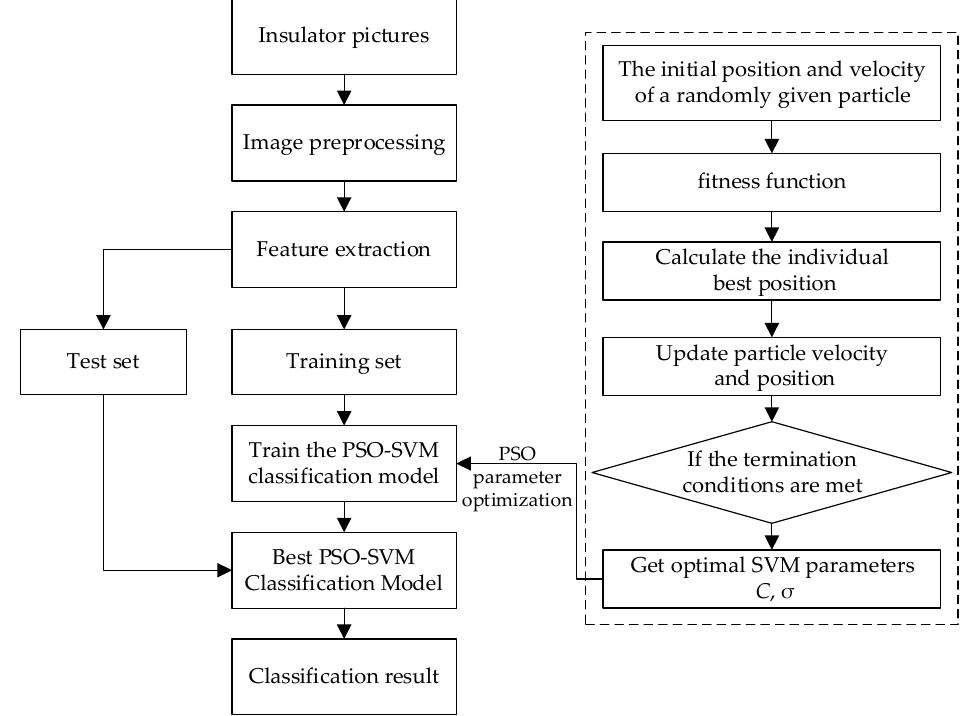
Figure 7. Overall flow chart of insulator status identification.